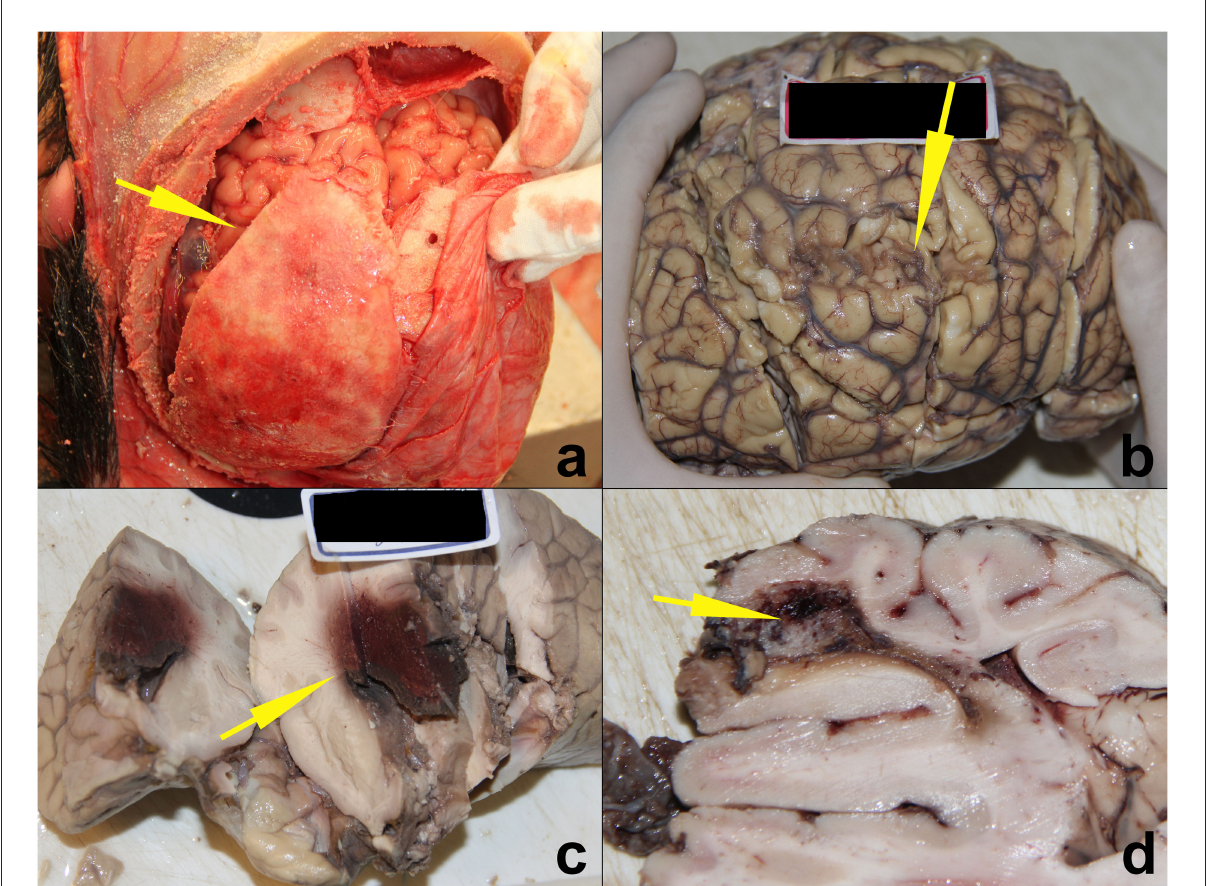
FIGURE4 Four SUDEP cases with typical epileptic brain lesions. (a) Epilepsy secondary to chronic subdural hematoma ossification. (b) Epilepsy secondary to old cerebral contusions. (c) Epilepsy secondary to cerebral glioma. (d) Epilepsy secondary to vascular malformation. All lesions are indicated by yellow